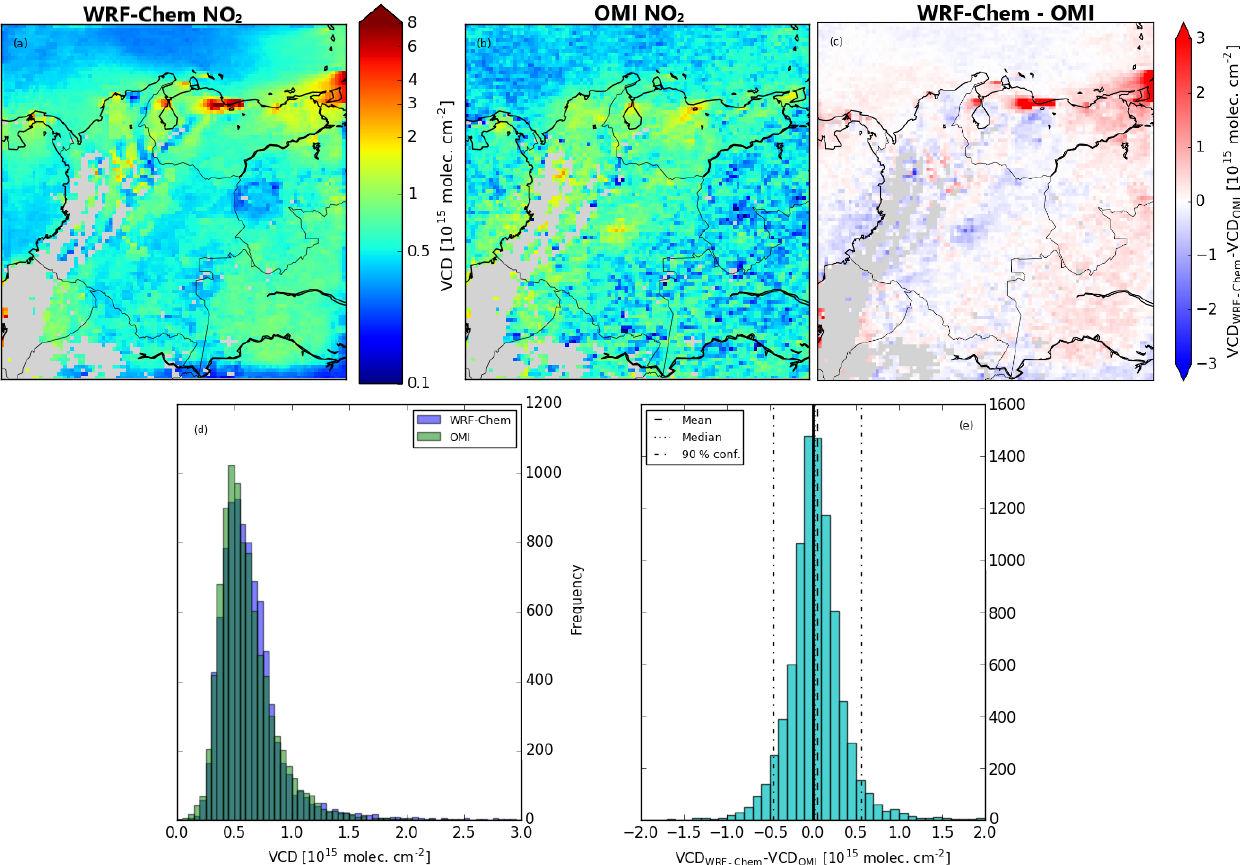
Figure 5. Spatial distribution of averaged cosampled NO 2 vertical column densities (VCDs; 10 15 moleculescm − 2 ) for (a) WRF-Chem, (b) OMI recalculated retrievals and (c) the absolute difference (WRF-Chem minus OMI) between the two and (d) the frequency distribution of both WRF-Chem and OMI over the whole domain and (e) the distribution of the absolute difference between the two per grid point, including mean (broken line), median (dotted line) and 90% confidence interval (broken and dotted